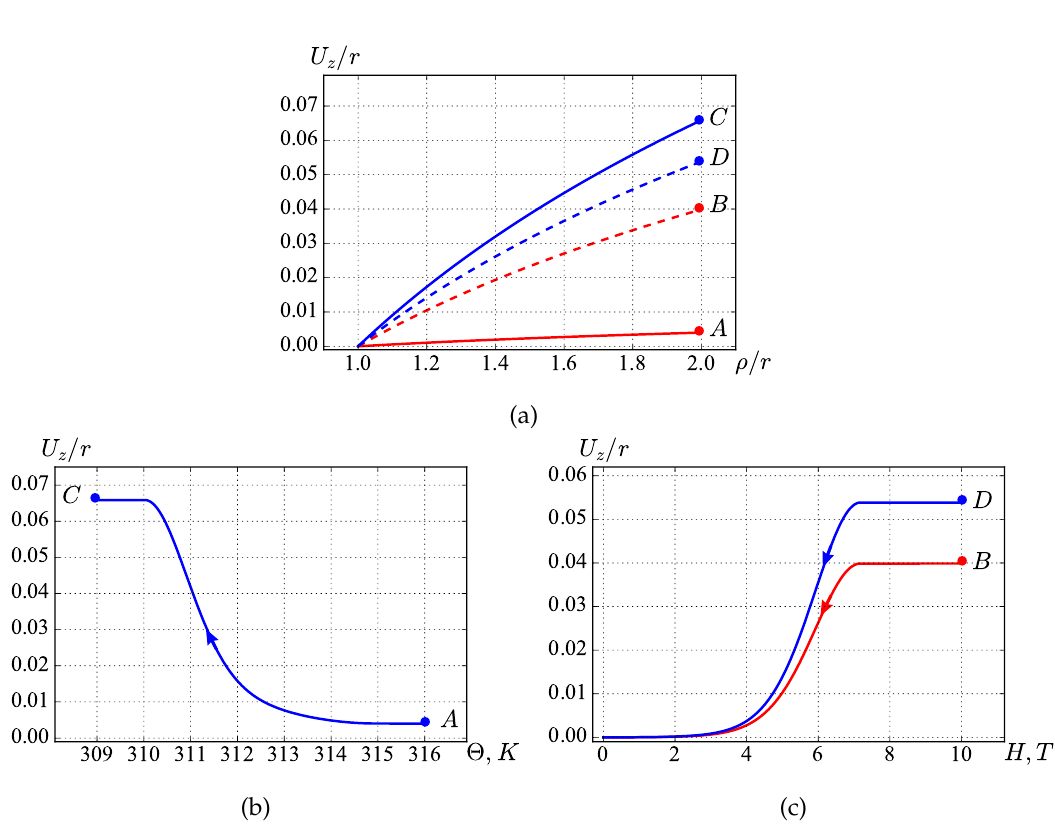
Figure 4. Displacements in the sample: distribution along the radius ( a ) and dependence on temperature ( b ) and on the magnetic field ( c